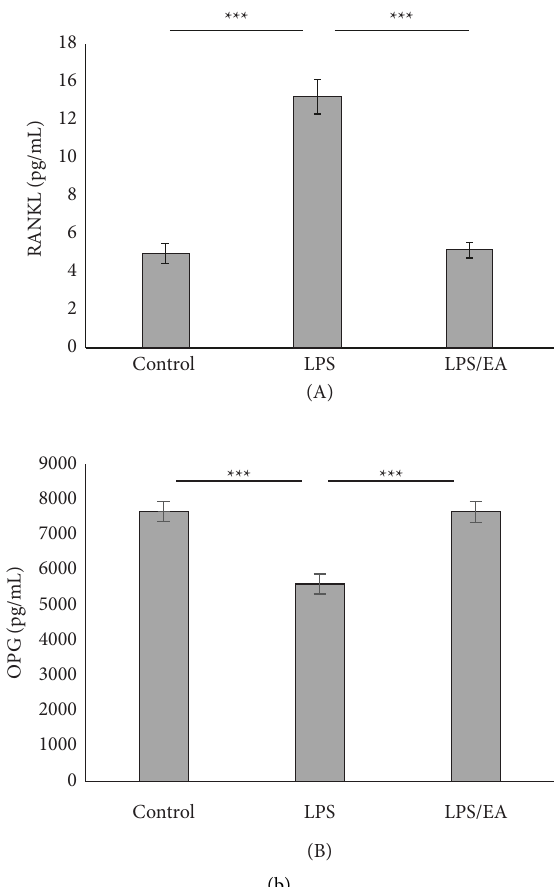
Figure 3: Efect of Equisetum arvense extract (EA) on osteoclast formation-related factors. (a) It has been reported that stimulation of osteoblasts with lipopolysaccharide (LPS) alters the expression of osteoclast formation-related factors. Terefore, we examined the efect of EA on osteoclast formation-related factors. Tumor necrosis factor- α , interleukin (IL)-6, and the receptor activator of NF- κ B ligand (RANKL) mRNA expression of ST2 stimulated with Escherichia coli ( E . coli )-LPS (1 μ g/mL) with or without EA (3 μ g/mL) for 2 hours, and total RNAs are extracted (A, B, C). IL-1 β and Sema3A mRNA expression of ST2 stimulated with E . coli -LPS with or without EA for 12 hours, and total RNAs are extracted (D, F). Osteoprotegerin (OPG) mRNA expression of ST2 stimulated with E . coli -LPS with or without EA for 24 hours, and total RNAs are extracted (E). Glyceraldehyde 3-phosphate dehydrogenase (GAPDH) is used as an internal control. Data are presented as means ± standard error ( n � 7 for each group). Tukey–Kramer multiple comparison test, ∗∗∗ p < 0 . 001, ∗∗ p < 0 . 01, ∗ p < 0 . 05. (b) RANKL and OPG protein expression of ST2 stimulated with Escherichia coli ( E . coli )-lipopolysaccharide (LPS) (1 μ g/mL). Cell culture supernatants were collected 3 hours (for RANKL) or 48 hours (for OPG) after treatment and analyzed using an ELISA assay. Data are presented as means ± standard error ( n � 6 for each group). Tukey–Kramer multiple comparison test, ∗∗∗ p < 0 .